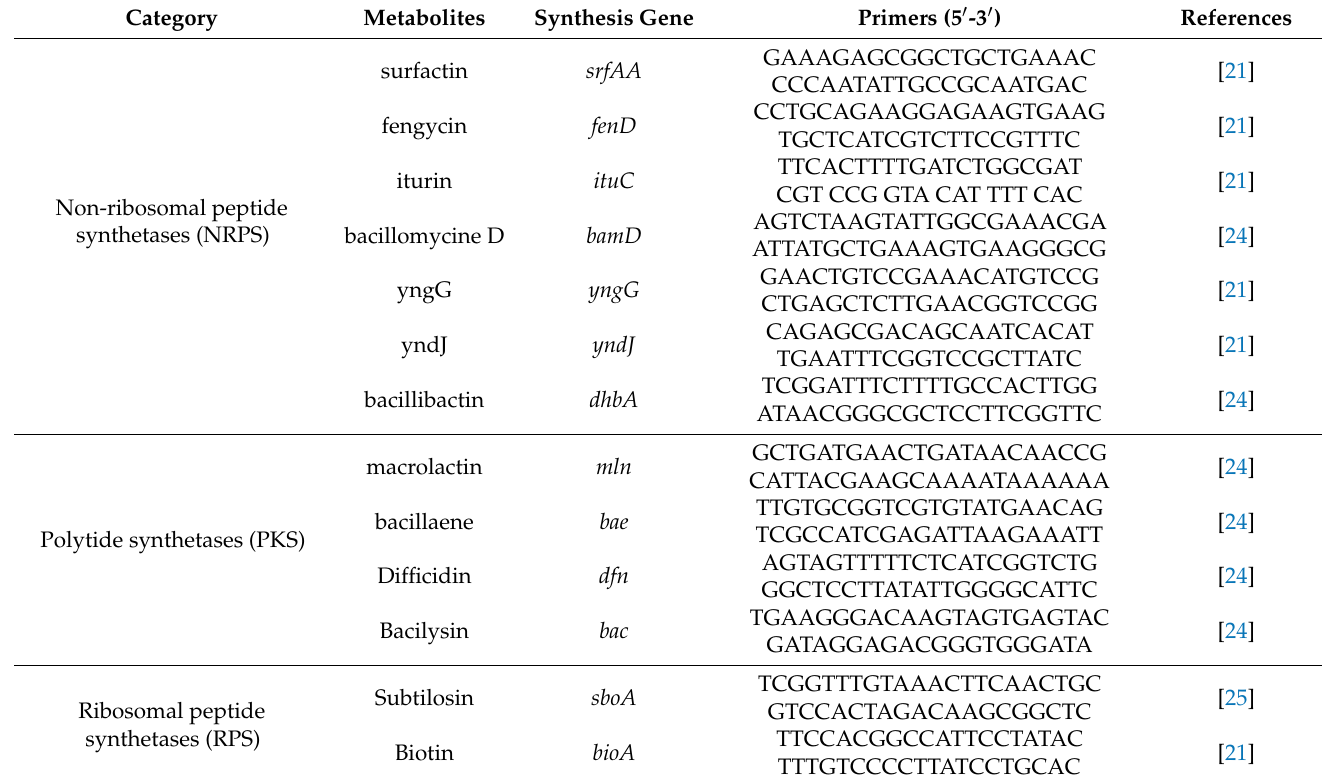
Table 1. The specific primers from target genes derived from